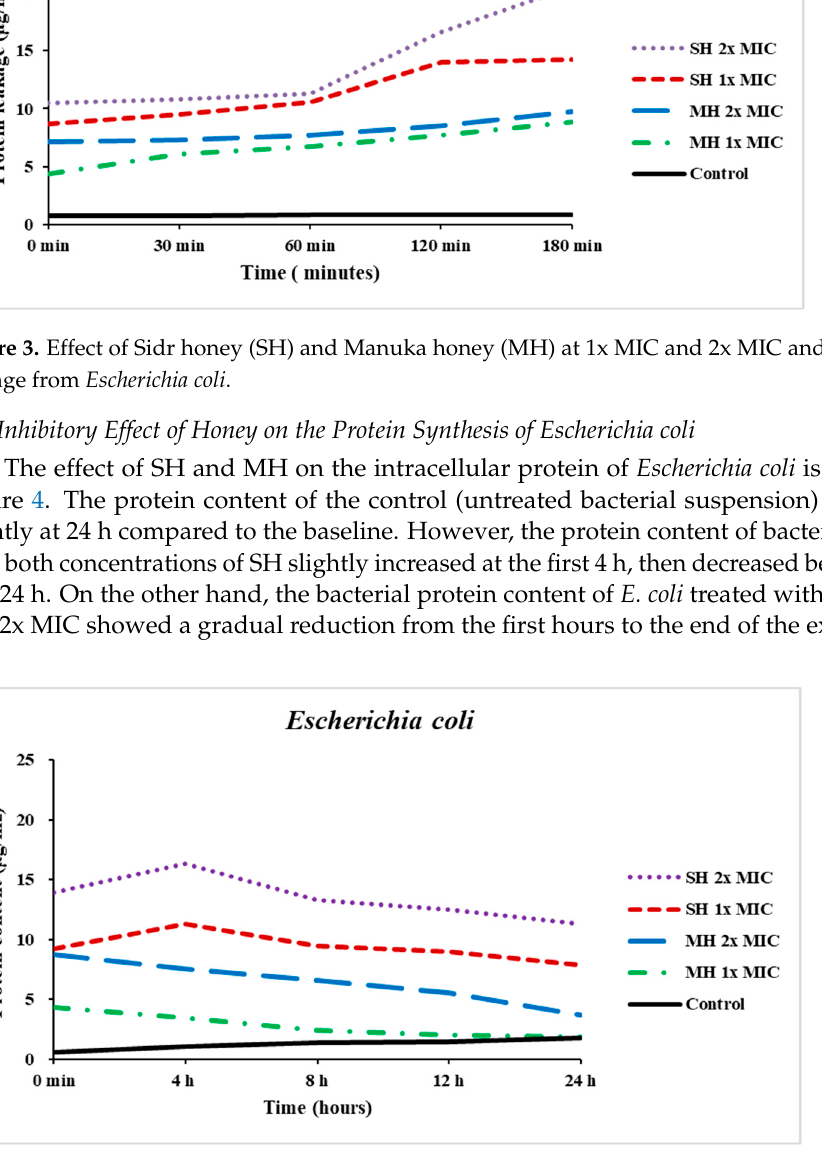
Figure 4. Effect of Sidr honey (SH) and Manuka honey (MH) at 1x MIC and 2x MIC and control on the bacterial protein content of Escherichia coli .